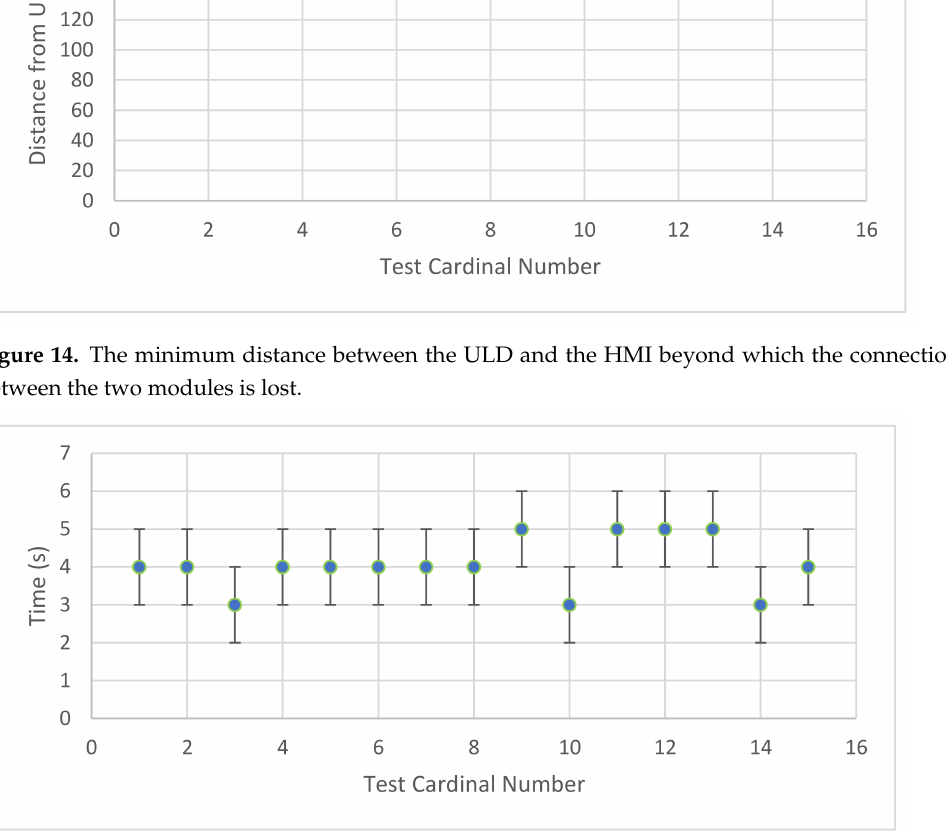
Figure 15. The time interval between the HMI–ULD connection restoration and the first report receipt in the